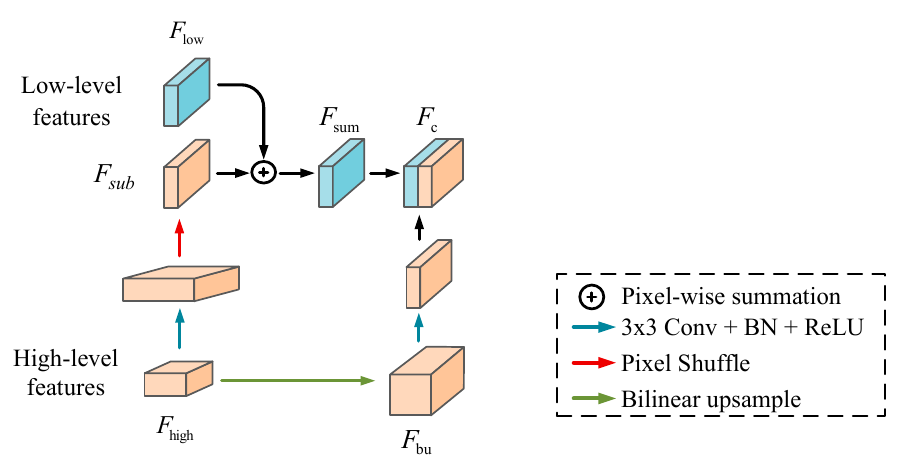
Figure 3. The architecture of dual-path upsampling block (DU block).